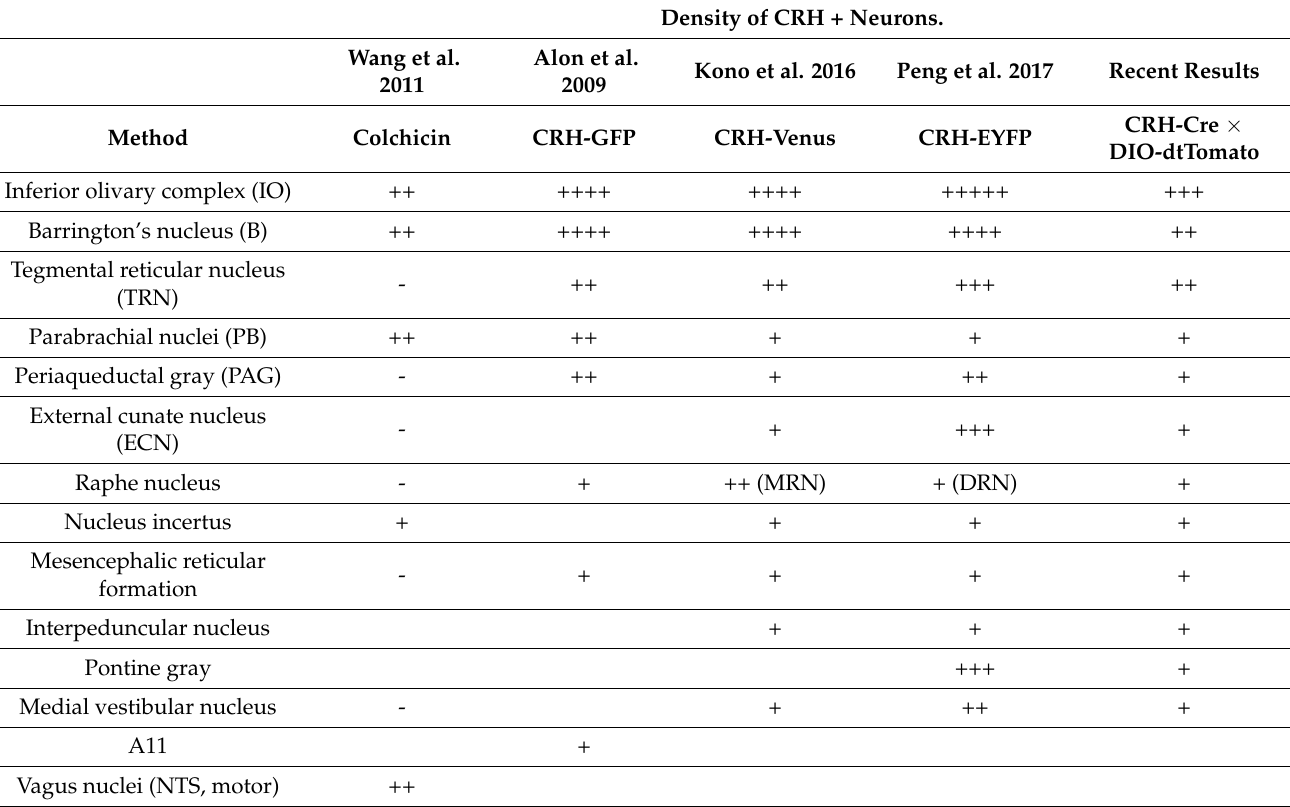
Table 1. Brainstem regions of the mouse that contains CRH-positive neurons. Density of CRH +